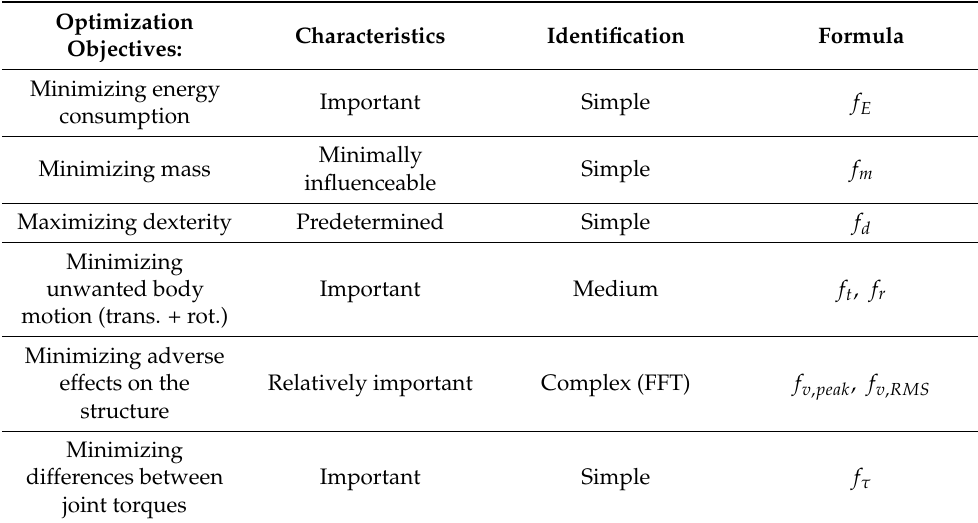
Table 4. The optimization